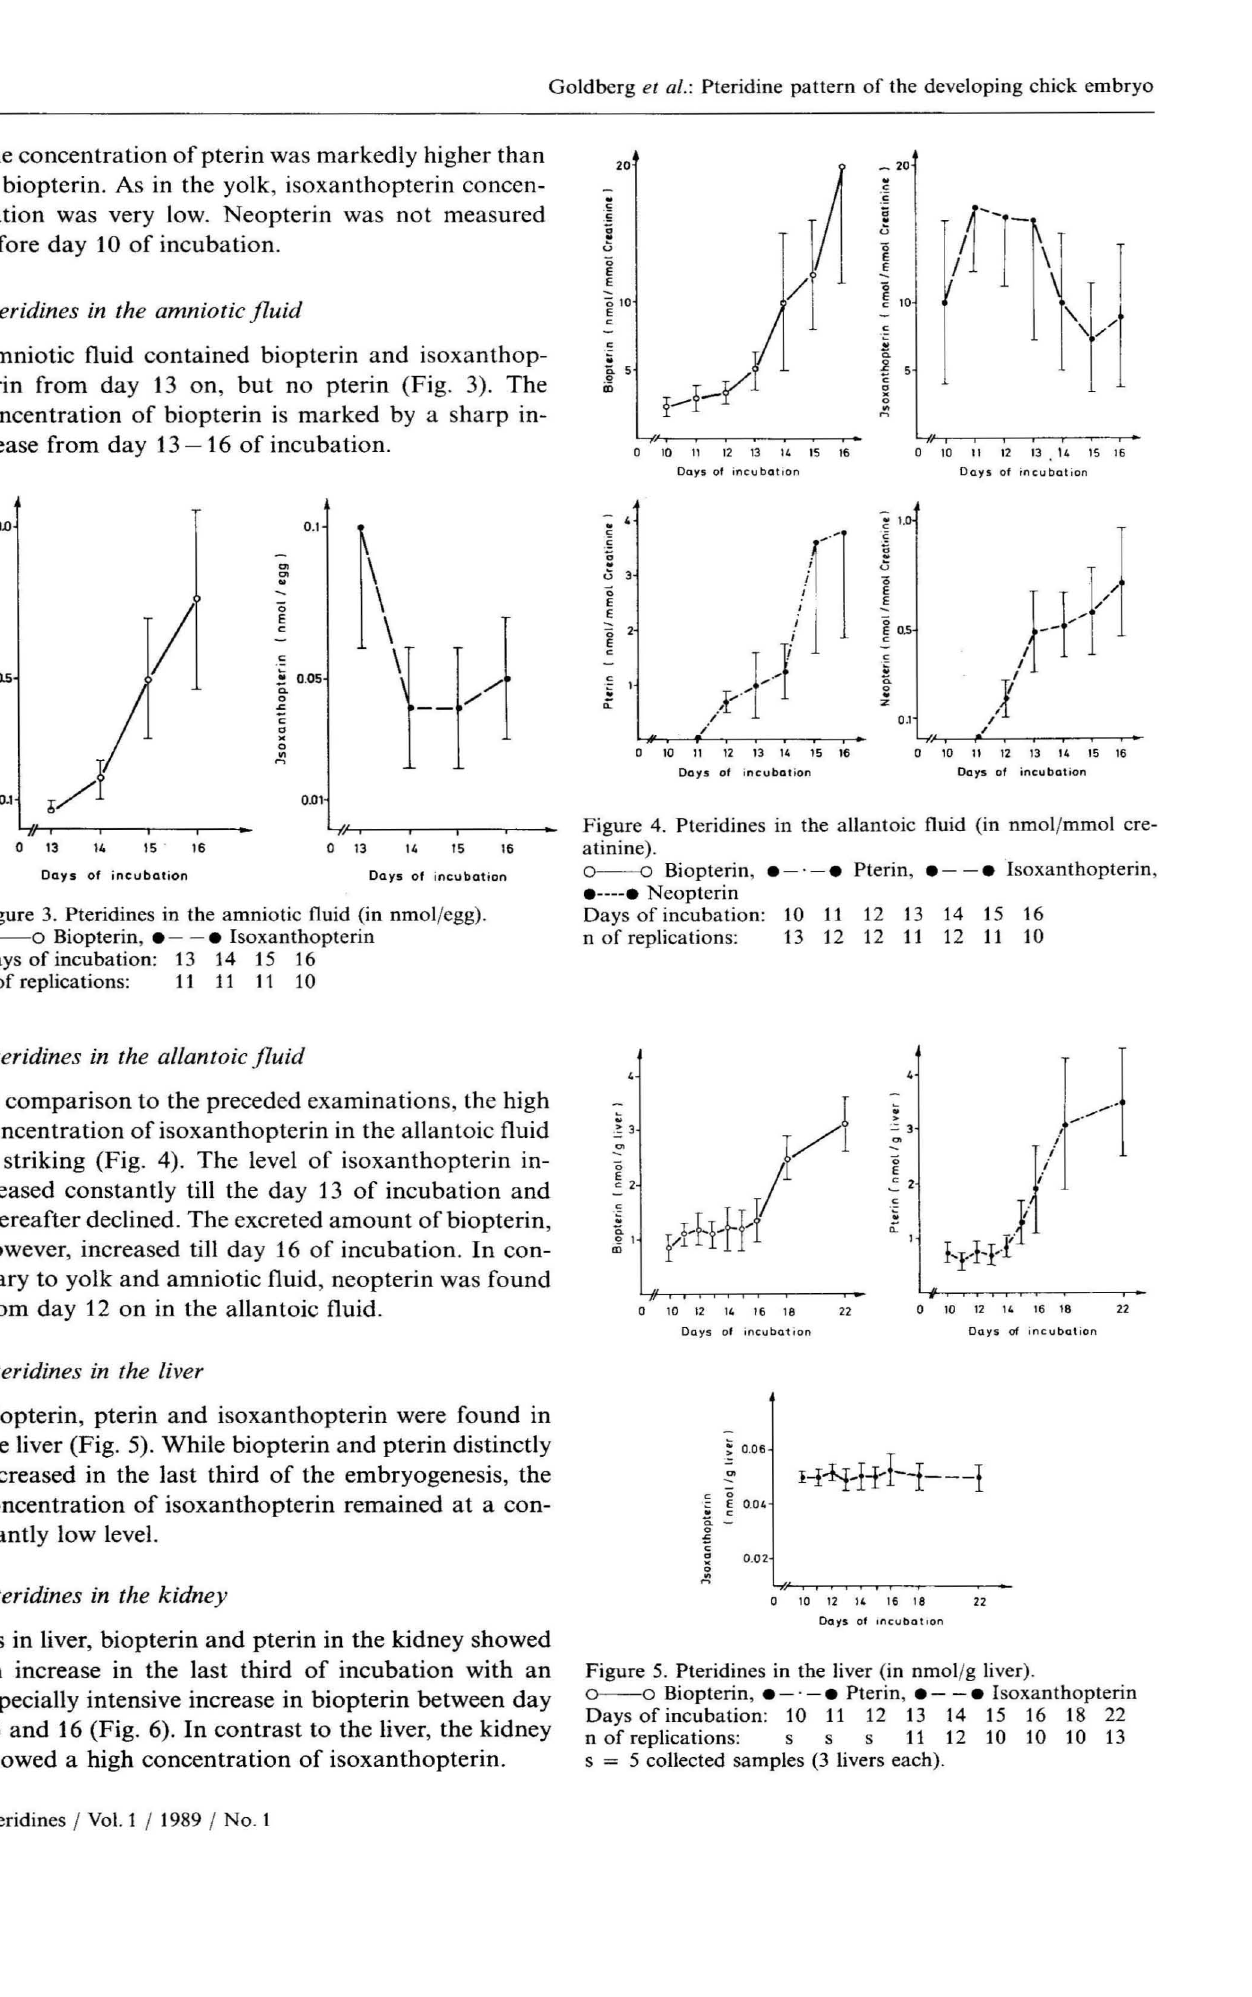
Figure 5. Pteridines in the liver (in nmol/g liver). 0-0 Biopterin, • - . -. Pterin, • - -. Isoxanthopterin Days of incubation: 10 11 12 13 14 15 16 18 22 n of